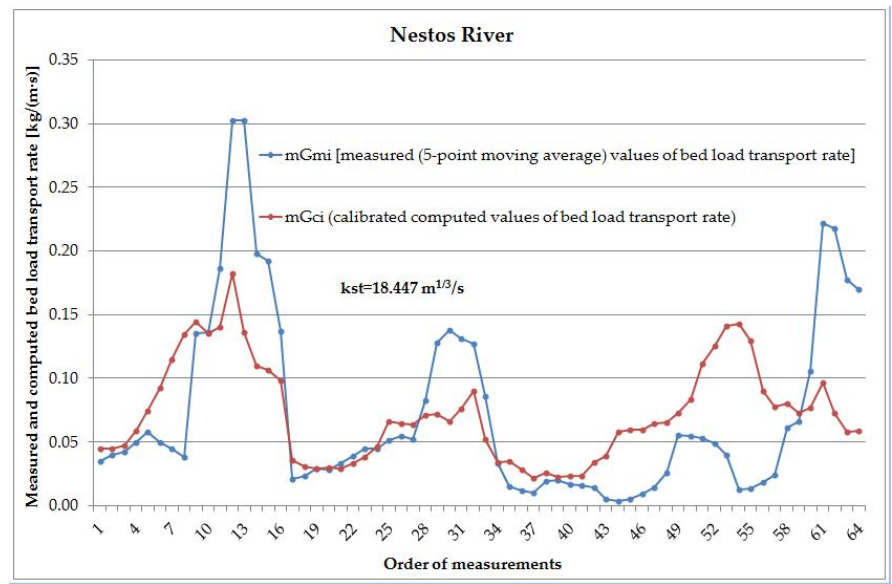
Figure 2. Measured (5 ‐ point moving average) and calibrated computed values of bed load transport rate of Nestos River.